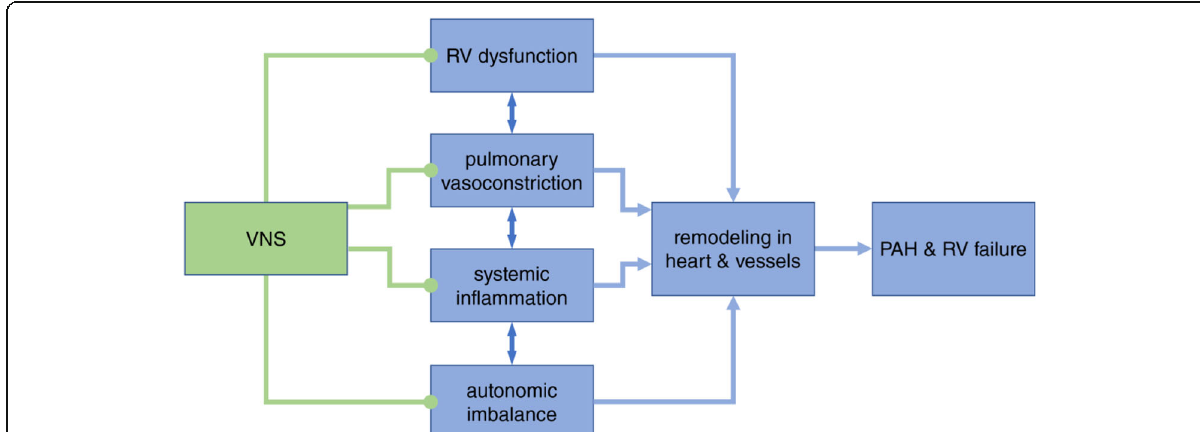
Fig. 2 Potential actions of VNS on different pathogenetic mechanisms involved in PAH. Pulmonary arterial vasoconstriction, right ventricular (RV) dysfunction and systemic inflammation are core mechanisms in the pathogenesis of PAH. They may be related to autonomic imbalance that is common in PAH, with an increased sympathetic and decreased parasympathetic tone. Vasoconstriction, RV dysfunction and inflammation lead to remodeling in the RV and pulmonary vessels, which eventually exacerbate the pathophysiology of PAH. In principle, VNS could target therapeutically these mechanisms in the following ways: VNS produces NO-mediated vasodilation in the pulmonary circulation via vagal bronchopulmonary branches. VNS renormalizes RV function via efferent and possibly afferent cardiac vagal fibers. VNS down-modulates cytokine- mediated immune response via branches that terminate in the spleen. VNS chronically restores autonomic imbalance, possibly via re-setting vagal and non-vagal autonomic reflexes between the brain and